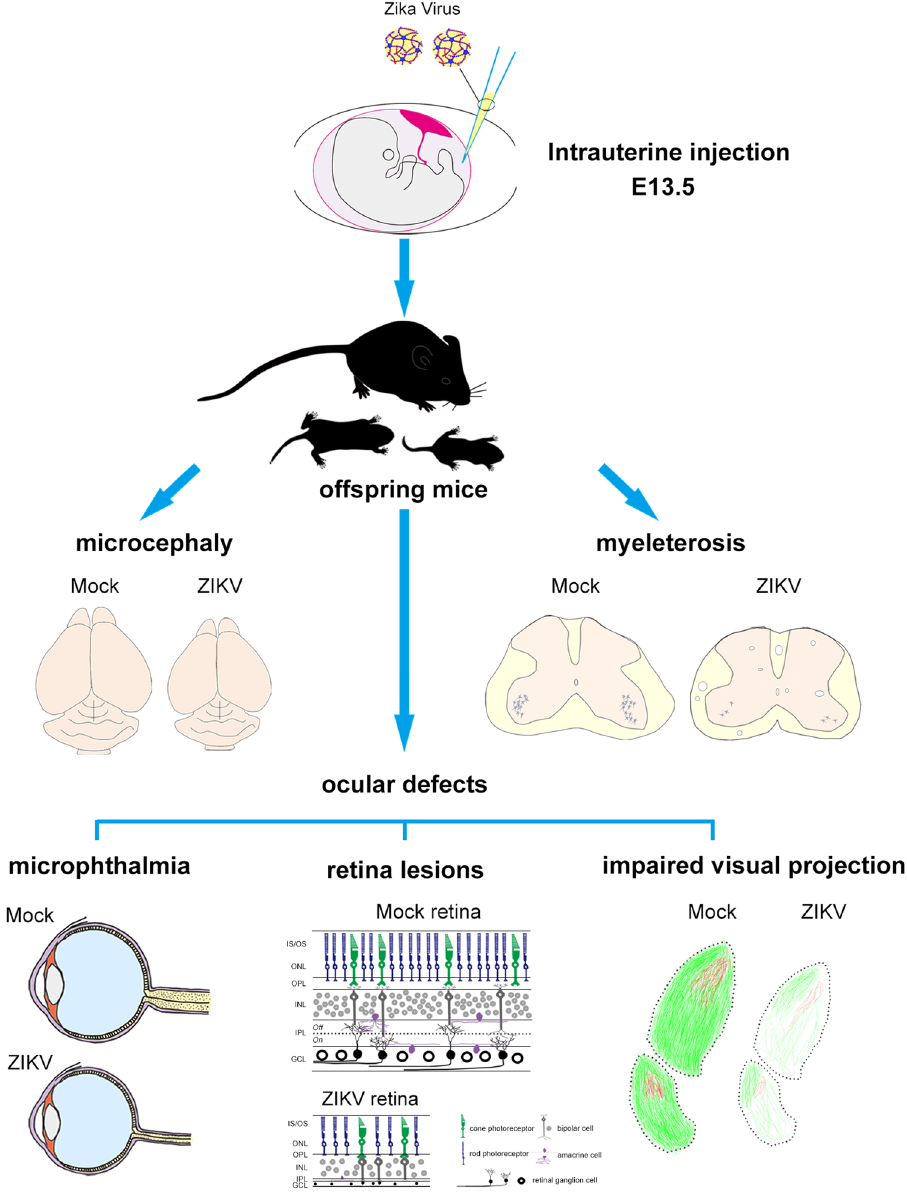
Figure 7. Schematic summary of offspring pathological phenotypes caused by intrauterine ZIKV